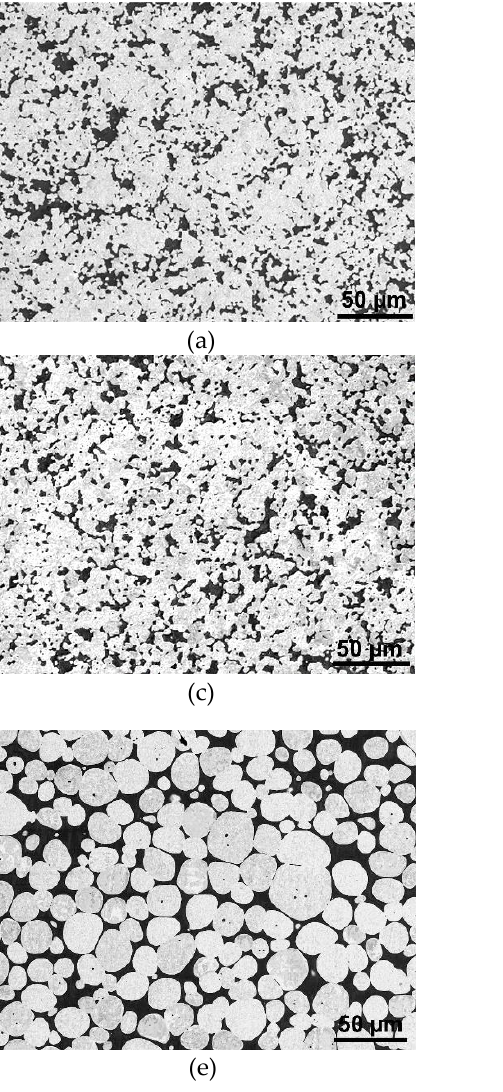
Figure 6. Structure scans of individual quenched pieces sintered at: 1450 °C/30 min ( a ); 1475 °C/30 min ( b ); 1500 °C/30 min ( c ); 1500 °C/180 min ( d ); 1525 °C/30 min ( e ); 1550 °C/30 min ( f ). ( b ); 1500 ◦ C / 30 min ( c ); 1500 ◦ C / 180 min ( d ); 1525 ◦ C / 30 min ( e ); 1550 ◦ C / 30 min ( f